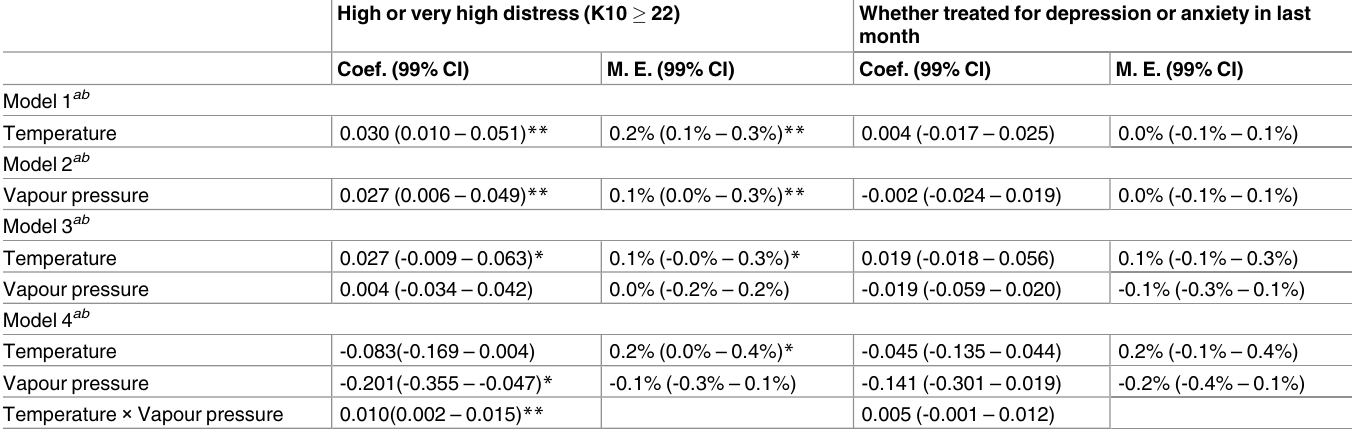
Table 2. The associations between temperature (heat), vapour pressure (humidity) and mental health, Logit model for 53,144 adults aged over 45 from NSW,